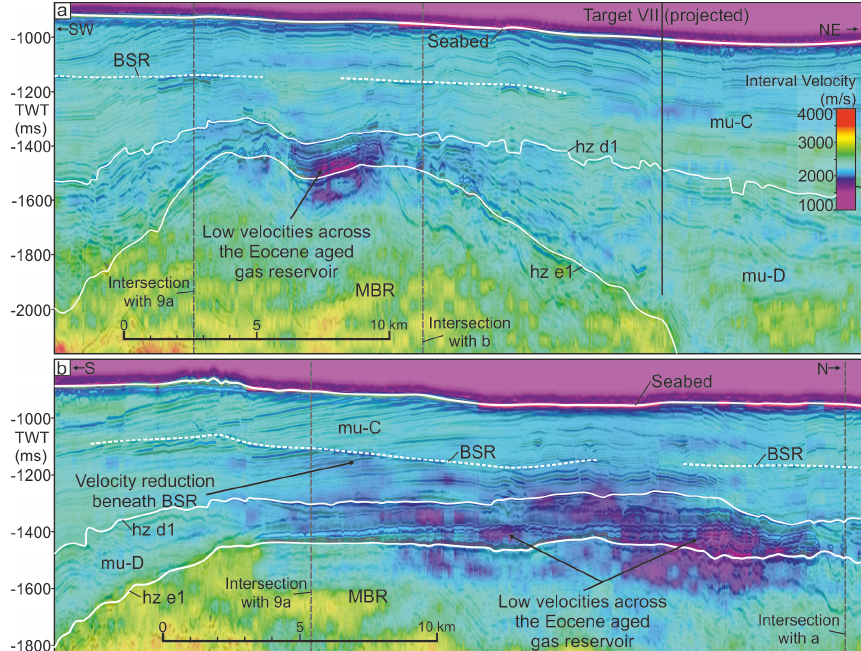
Figure 4. Interval velocities created through Kirchhoff pre-stack TTI depth migration (PSDM) for the Pitu survey overlaid on seismic reflection dip (a) and strike lines (b) in two-way time across the Melville Bay Ridge structure. Velocity reduction likely due to the presence of gas can be observed in the location of the Eocene-aged reservoir on top of the ridge as well as beneath a bottom-simulating reflector (BSR) within the free gas zone. The locations of panels (a) and (b) are shown in Figs. 3 and 9.